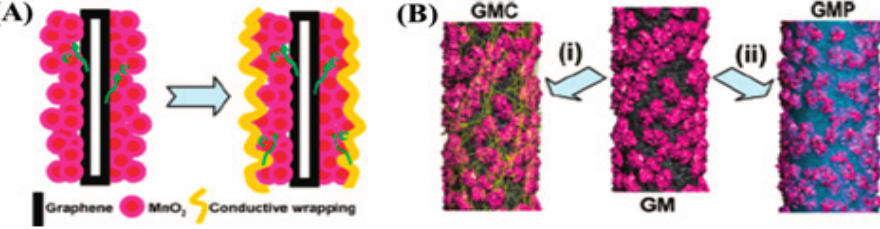
Figure 5. ( A ) Schematic illustration showing conductive wrapping of graphene/MnO 2 (GM) graphene/MnO 2 /CNT (GMC) and graphene/MnO 2 /conducting polymer (GMP)